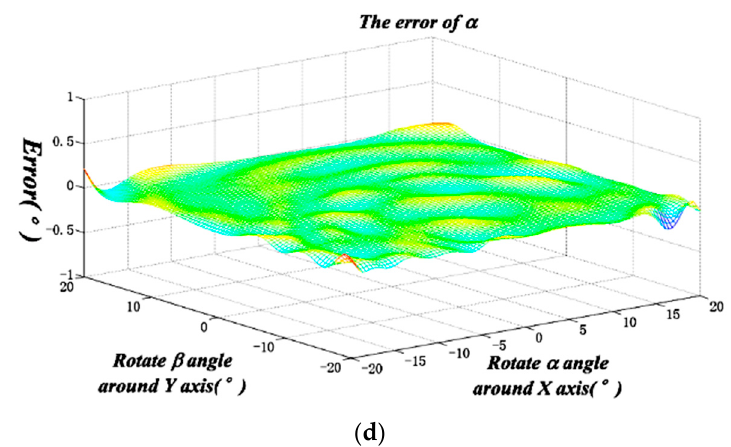
Figure 4. Output error diagram of BP ANN with different hidden layers. ( a ) Error diagram of a single hidden layer ; ( b ) error diagram of a double hidden layer ; ( c ) error diagram of three hidden layers ; ( d ) error diagram of four hidden layers.